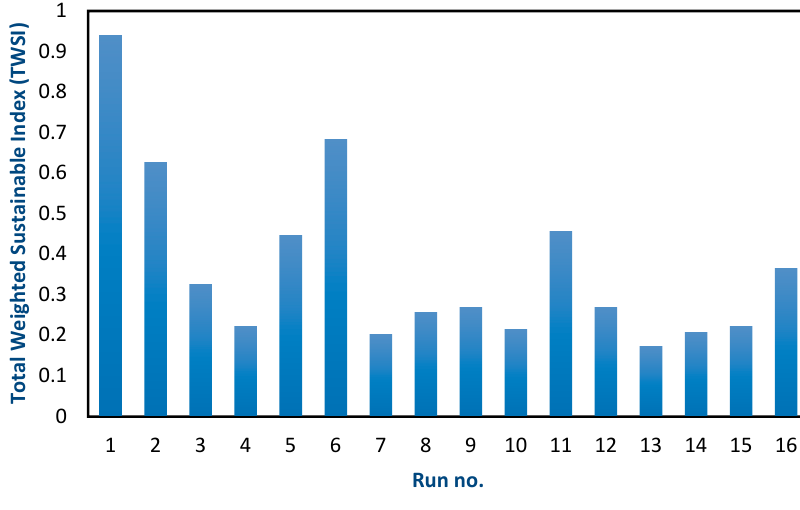
Figure 3. Sustainable indicators.